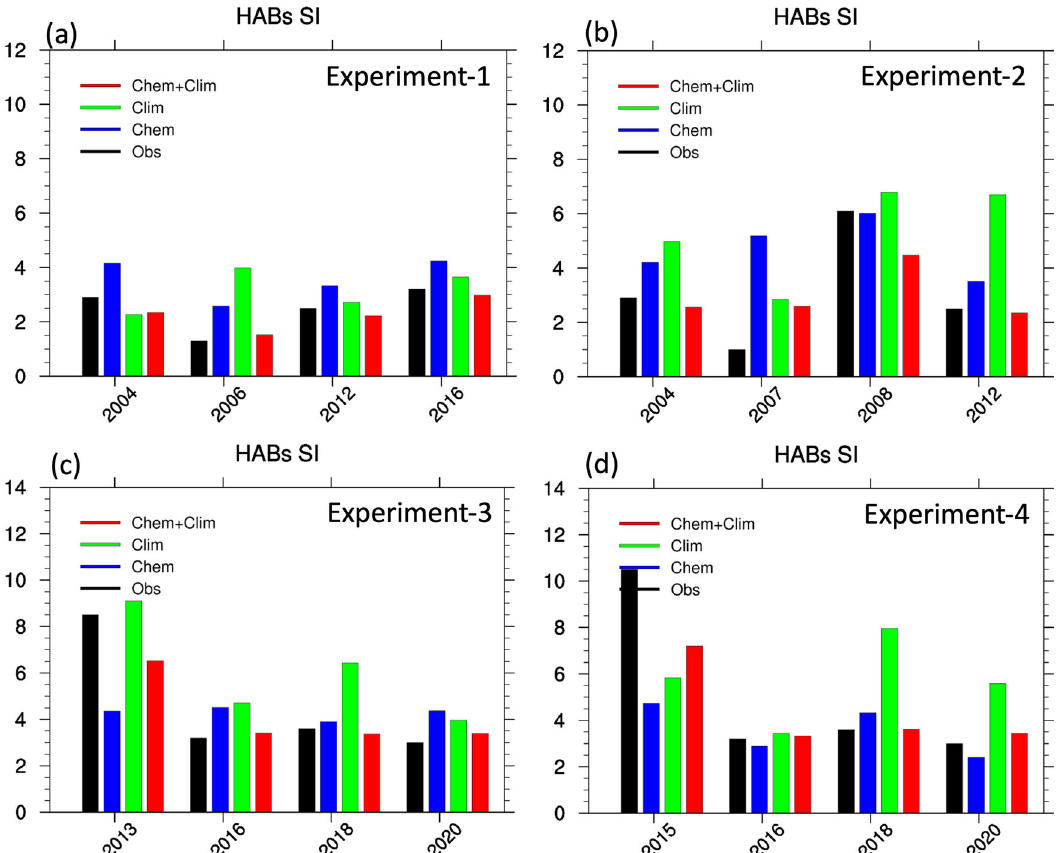
Fig. 5 Prediction of HABs severity index using different input parameters. a HABs severity index (SI) for Experiment-1 from observation (black bar), prediction using GA-chem model that is based on nutrient loading only (blue bar), prediction using GA-clim model that is based on climate indices only (green bar) and GA-chem-clim that is based on nutrient loading and climate indices (red bar). b Same as ( a ) but for Experiment-2. c Same as ( a ) but for Experiment-3. d Same as ( a ) but for Experiment-4. The years on x -axis show the predicted years for each of these four experiments.